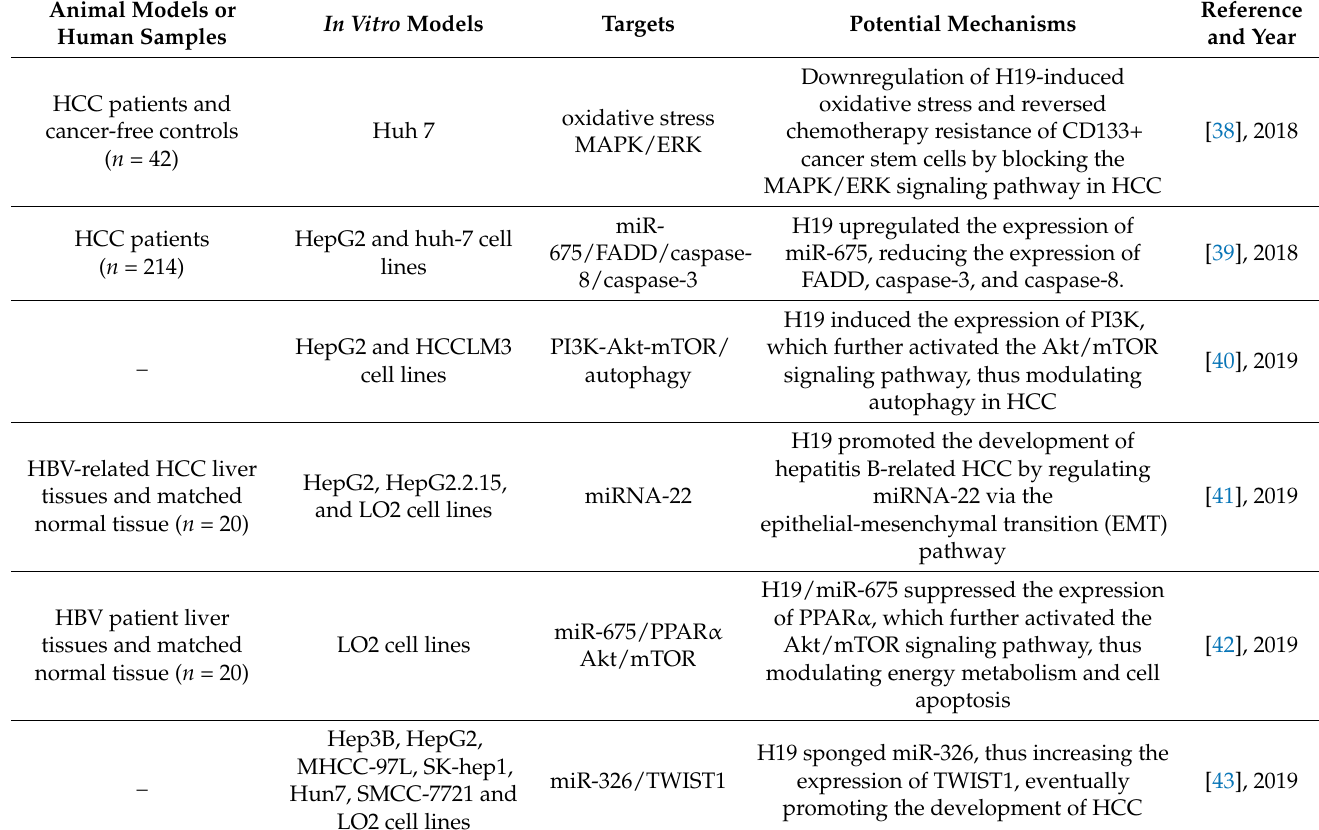
Table 1. Potential targets of lncRNA H19 in